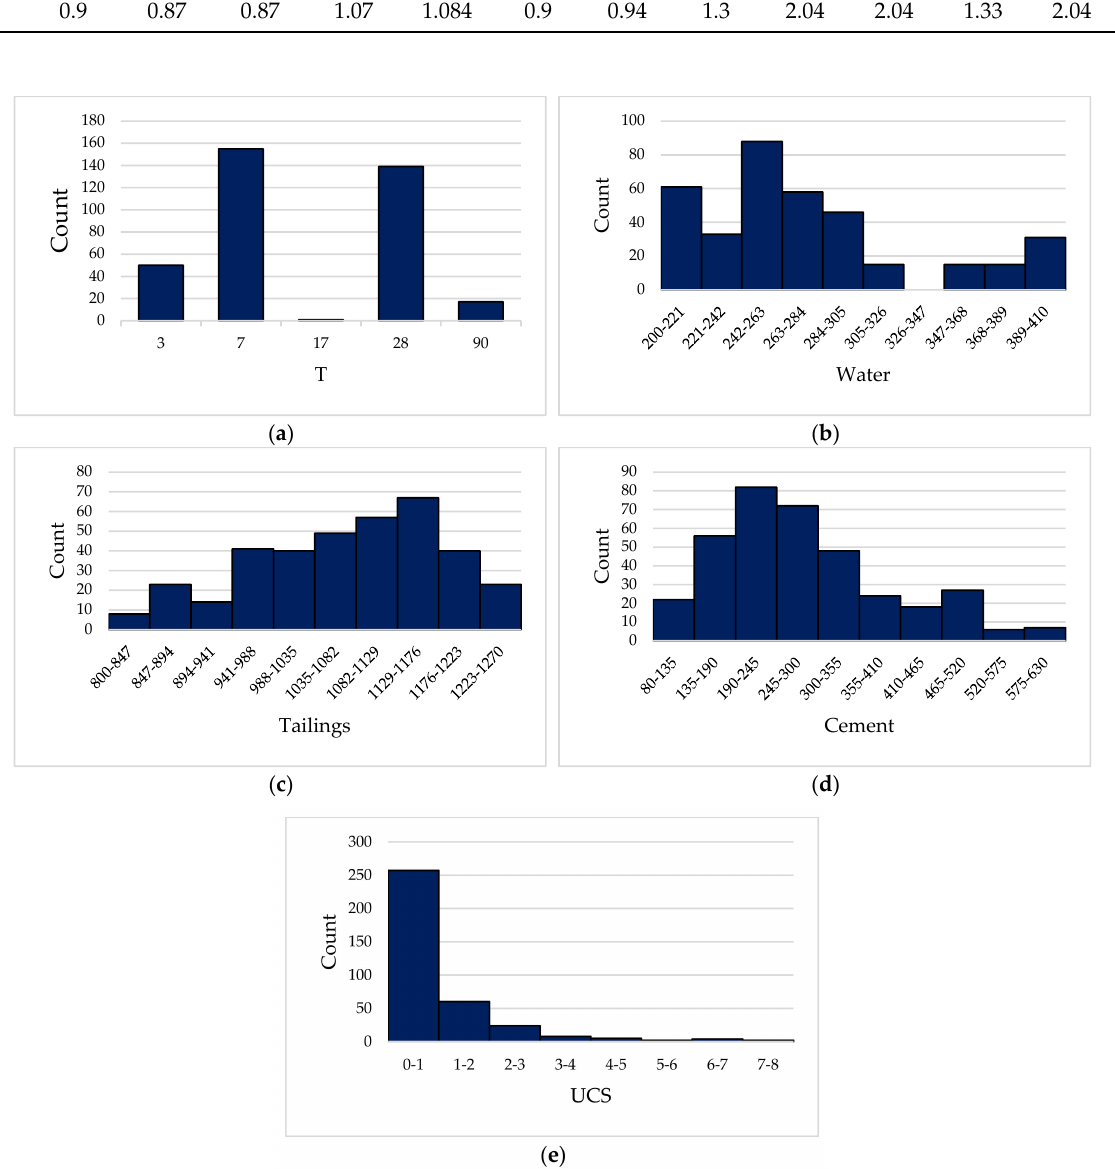
Figure 2. Frequency distribution histogram of input parameters (( a ): T; ( b ): Water; ( c ): Tailings; ( d ): Cement; ( e ):